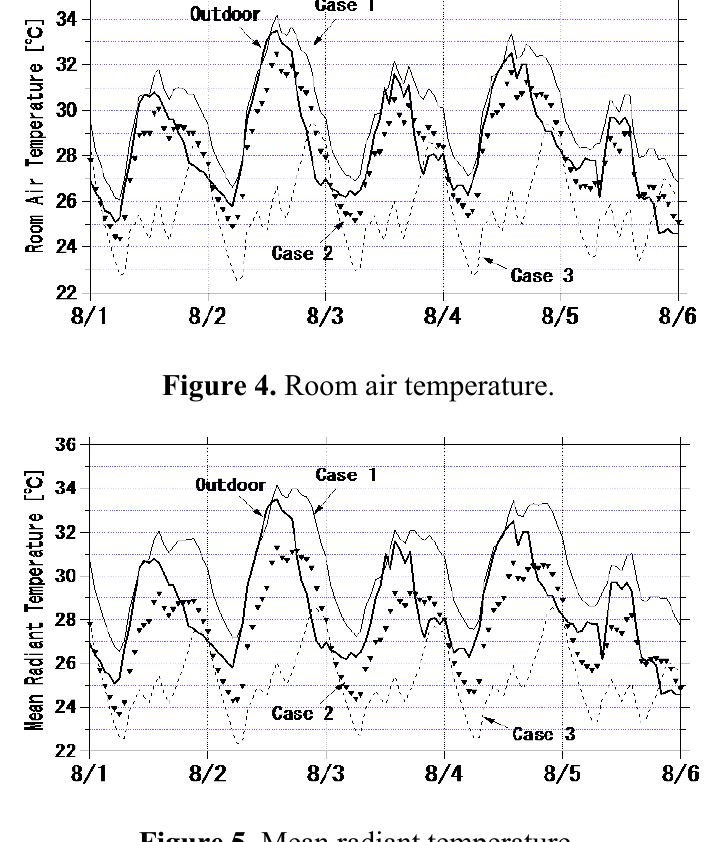
Figure 5. Mean radiant